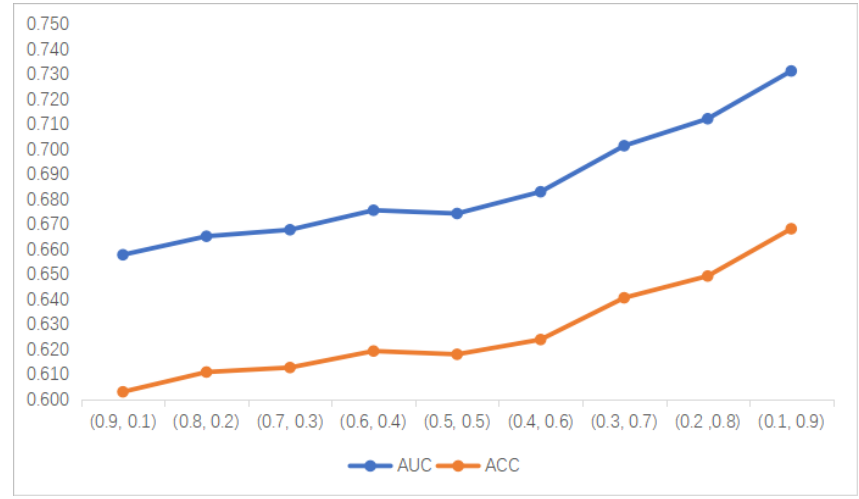
Figure 6. Impact of different hyperparameters on the performance of KGG model on Book-Crossing.